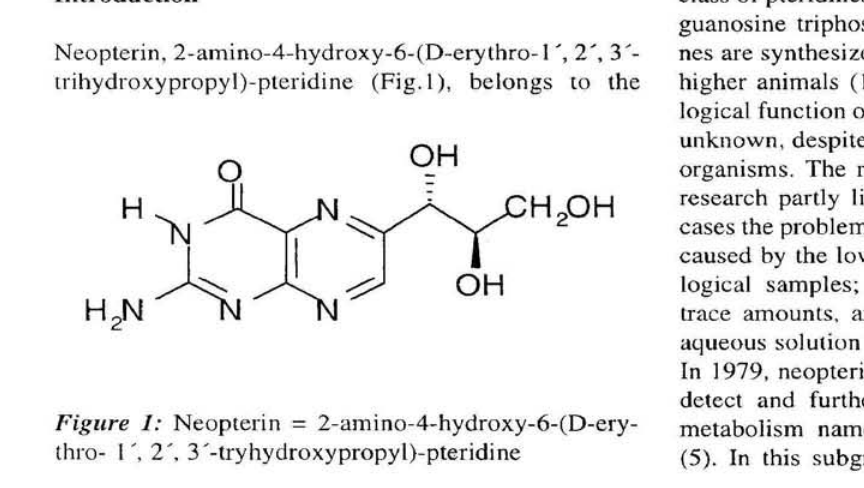
Figure 1: Neopterin = 2-amino-4-hydroxy-6-(D-ery- thro- 1', 2',